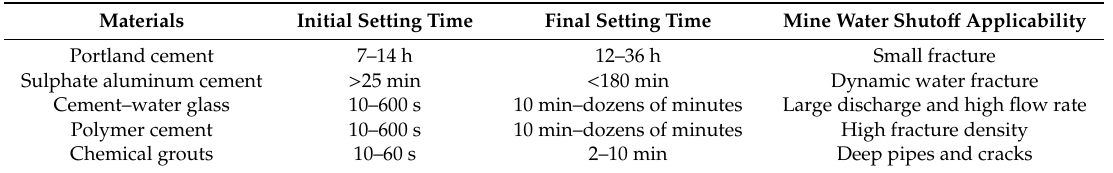
Table 1. Table of setting time and applicability of